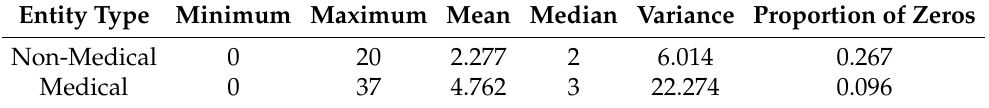
Table 2. Summary statistics.